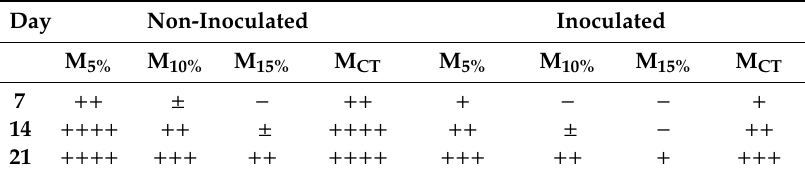
Table 6. Fungal growth in te ff mu ffi ns incubated at room temperature for 21 days. M 5% , mu ffi